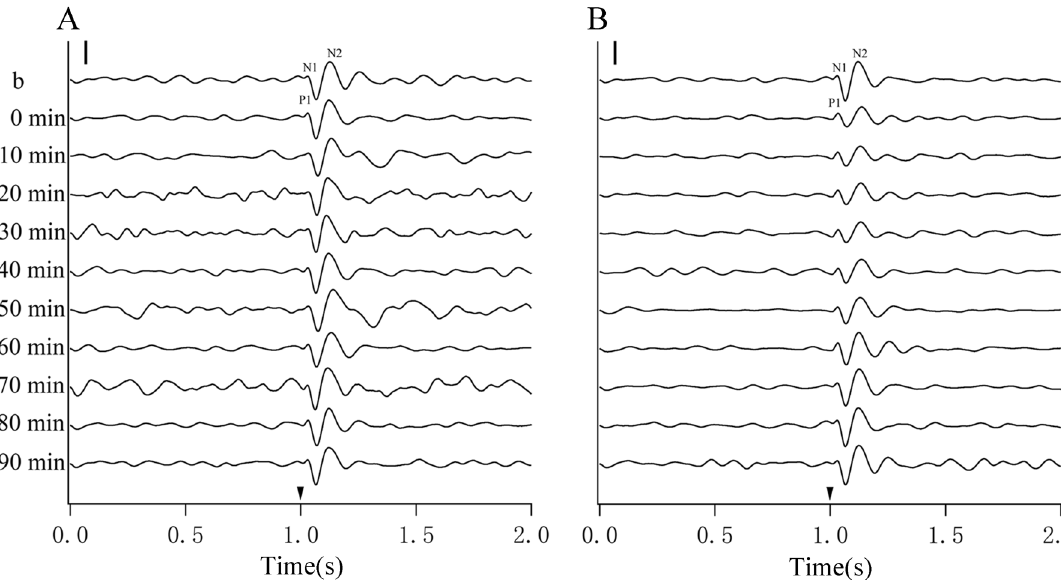
Figure 1. Samples of VEP voltage trace showing the three main components (wave N1, P1 and N2) and the changes of VEPs in the V1 cortex before (b) and at different time point (0, 10, 20, 30, 40, 50, 60, 70, 80 and 90 min) after the end of s-tDCS ( A ) and c-tDCS ( B ) in the area 7, respectively. Solid arrowheads indicate the onset of visual stimulation; The solid vertical scale bars in the upper left corner in A and B represent 100 μv. Image created using Igor (version 6.3.1.2, www. wavem etrics.